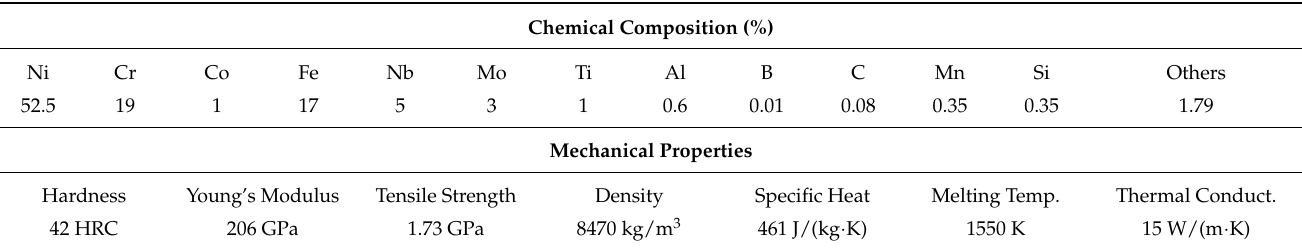
Table 1. Inconel ® 718 chemical composition and physical properties of tested alloy. Chemical Composition